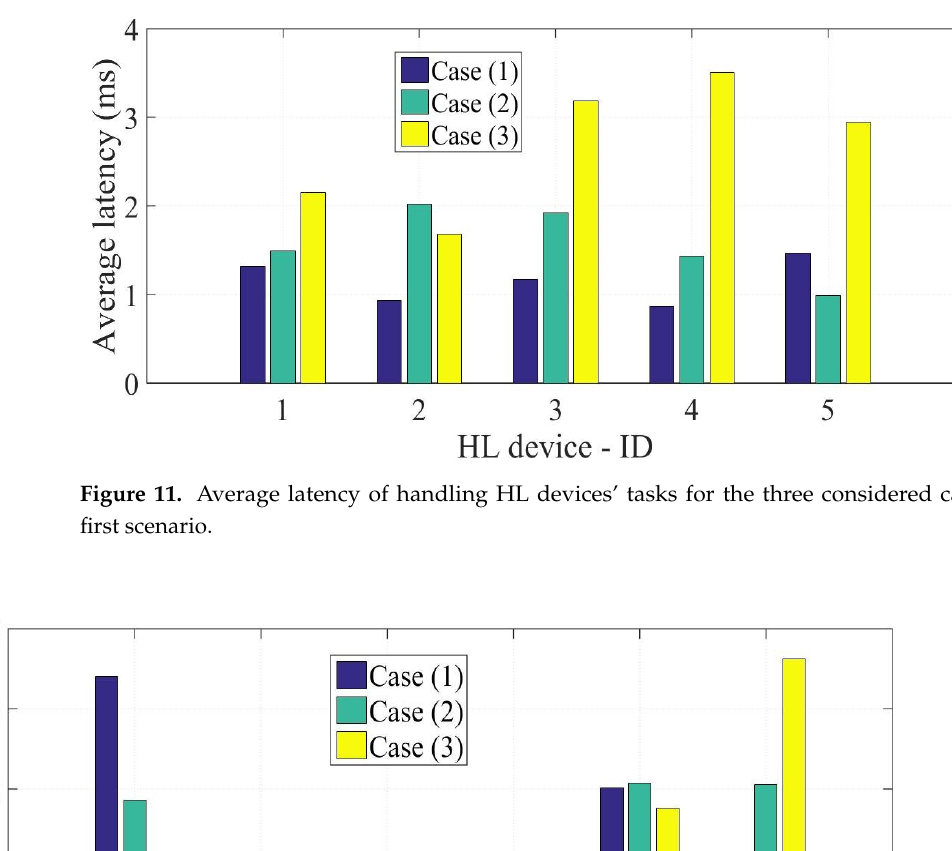
Figure 11. Average latency of handling HL devices’ tasks for the three considered cases of the first scenario.